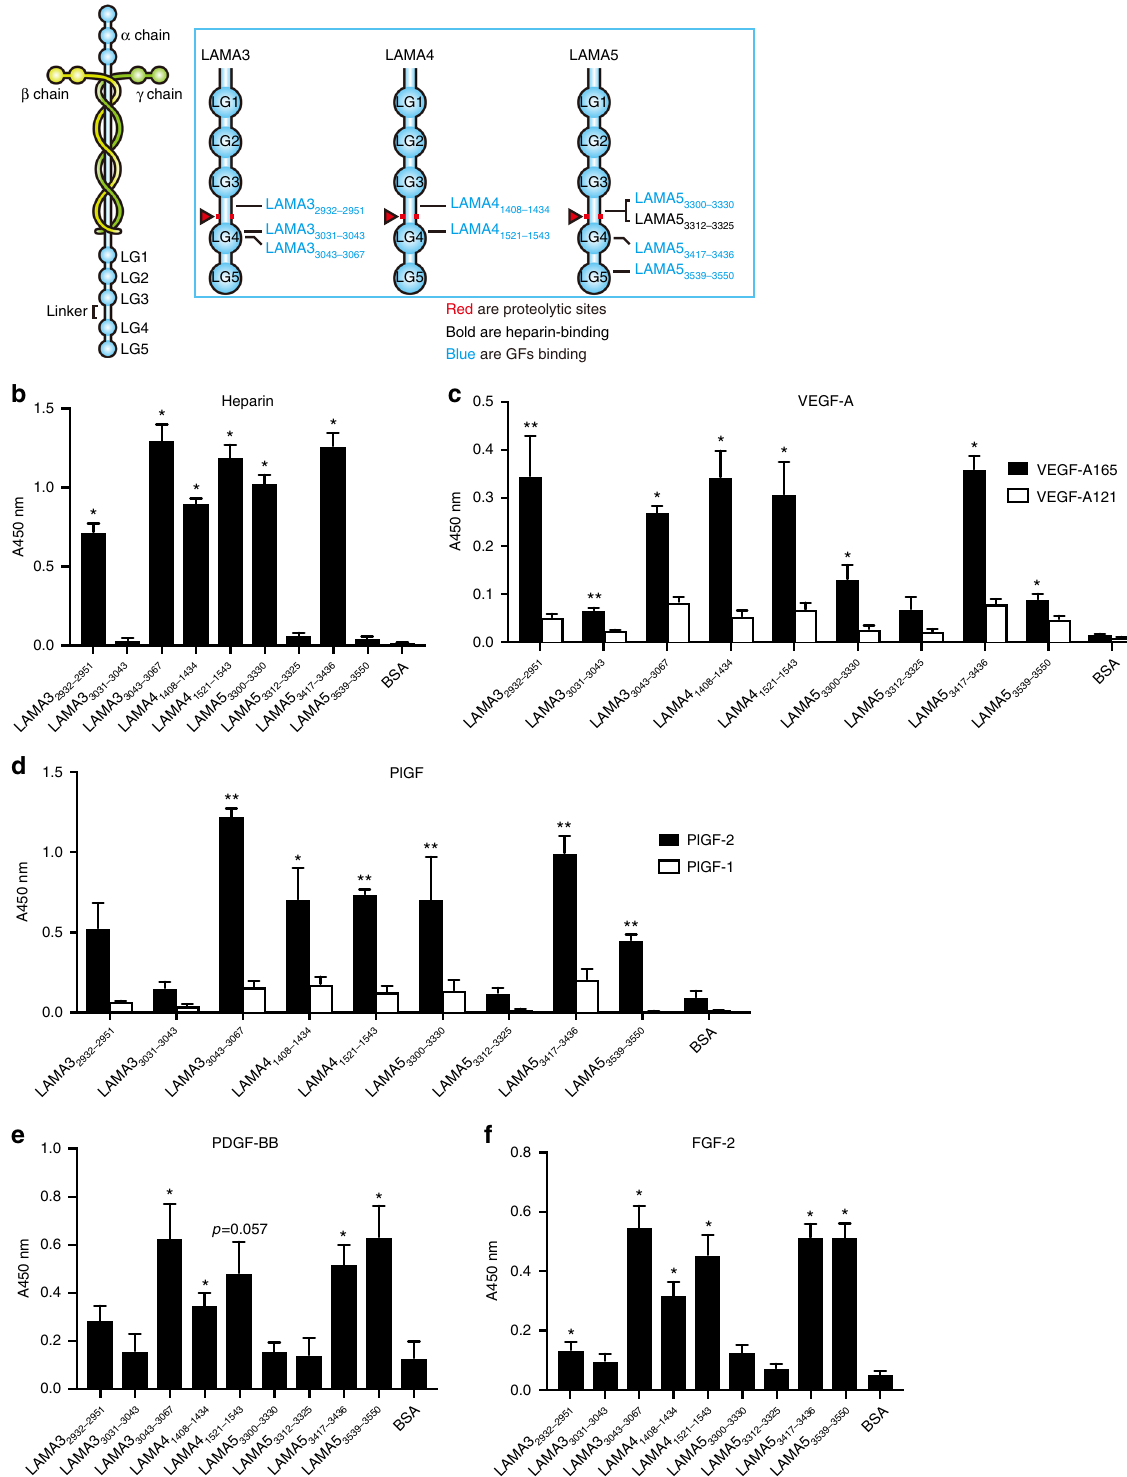
Fig. 4 GFs bind to laminin HBD derived from LAMA3, LAMA4, and LAMA5. a The location of laminin-derived peptides in the LG domain of LAMA3, LAMA4, and LAMA5 chains. b – f Af fi nity of heparin and GFs against chemically synthesized peptides derived from the LG domain of LAMA3, LAMA4, and LAMA5 chains. ELISA plates were coated with 10 µ g/mL laminin peptide and further incubated with b biotinylated heparin, c VEGF-A165 and VEGF-A121, d PlGF-2 and PlGF-1, e PDGF-BB, or f FGF-2. Concentrations were 1 μ g/mL for GFs and 10 µ g/mL for heparin. Bound heparin was detected with streptavidin, and bound GFs with a speci fi c antibody for each GF ( n = 4, mean ± SEM). Statistical analyses were performed using the Mann – Whitney U test by comparing the signals obtained from the laminin peptide- and the BSA-coated wells. * p < 0.05, ** p < 0.01. Two experimental